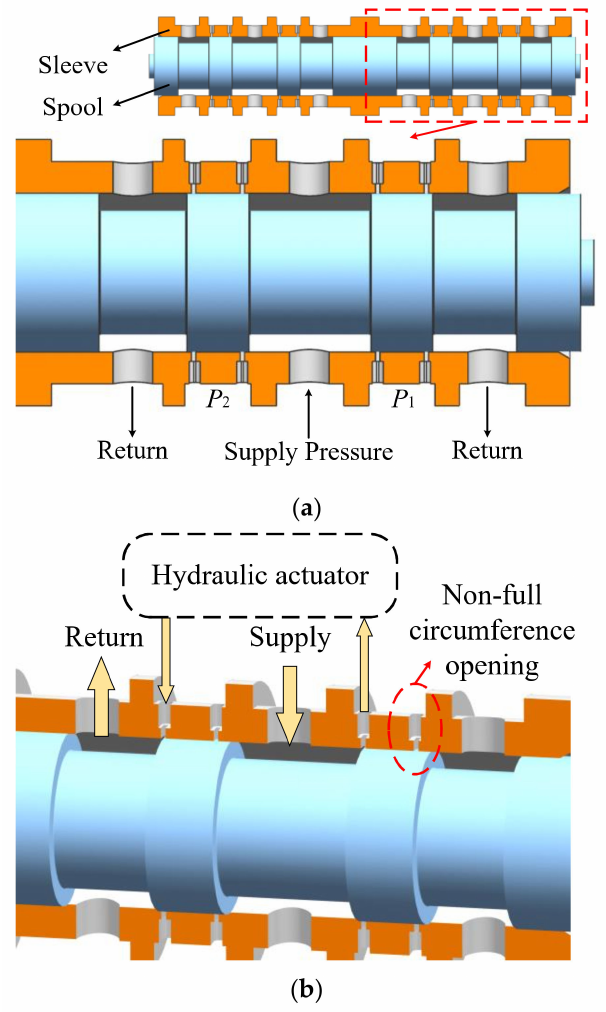
Figure 1. Geometry of direct drive servovalve: ( a ) Connection of two spools and geometry; ( b ) Flow in the valve chamber and valve